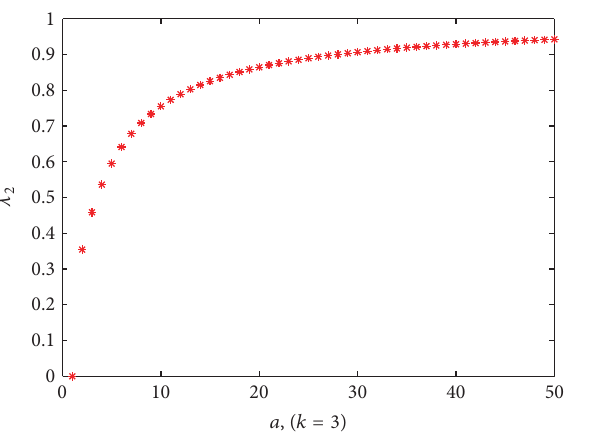
Figure 11: The variance of 𝐻 2 norm for 𝐾 3,3 ∘ 𝑃 𝑘 .